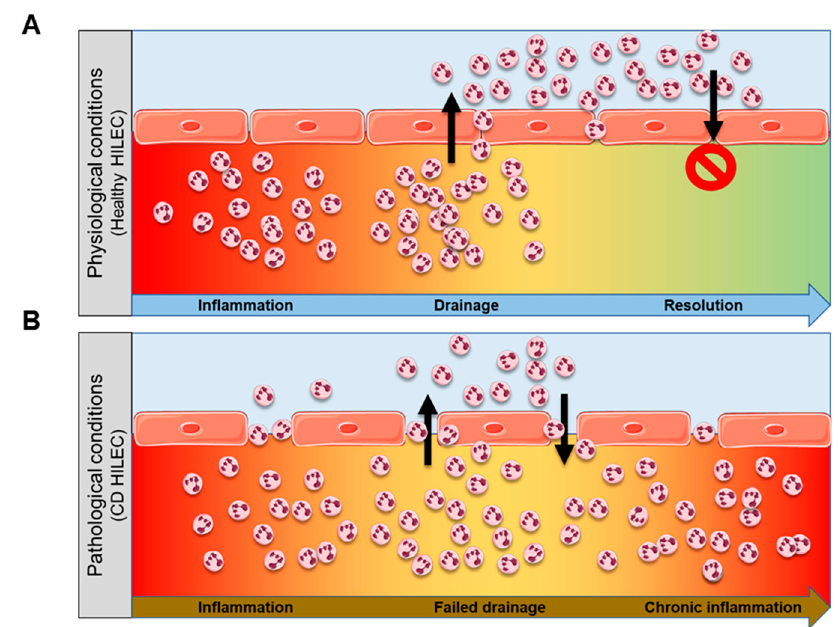
Figure 5. Lymphatic barrier is compromised in CD. Cartoons showing lymphatic drainage in physiological conditions ( A ) and in CD ( B ).